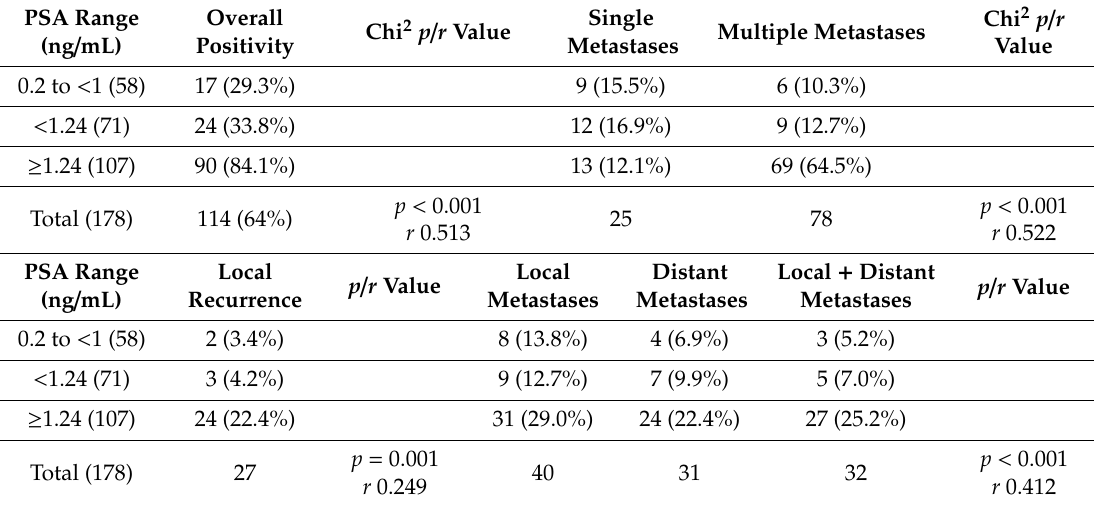
Table 5. Baseline PET / CT: LPR P-P of di ff erent subgroups related to PSA